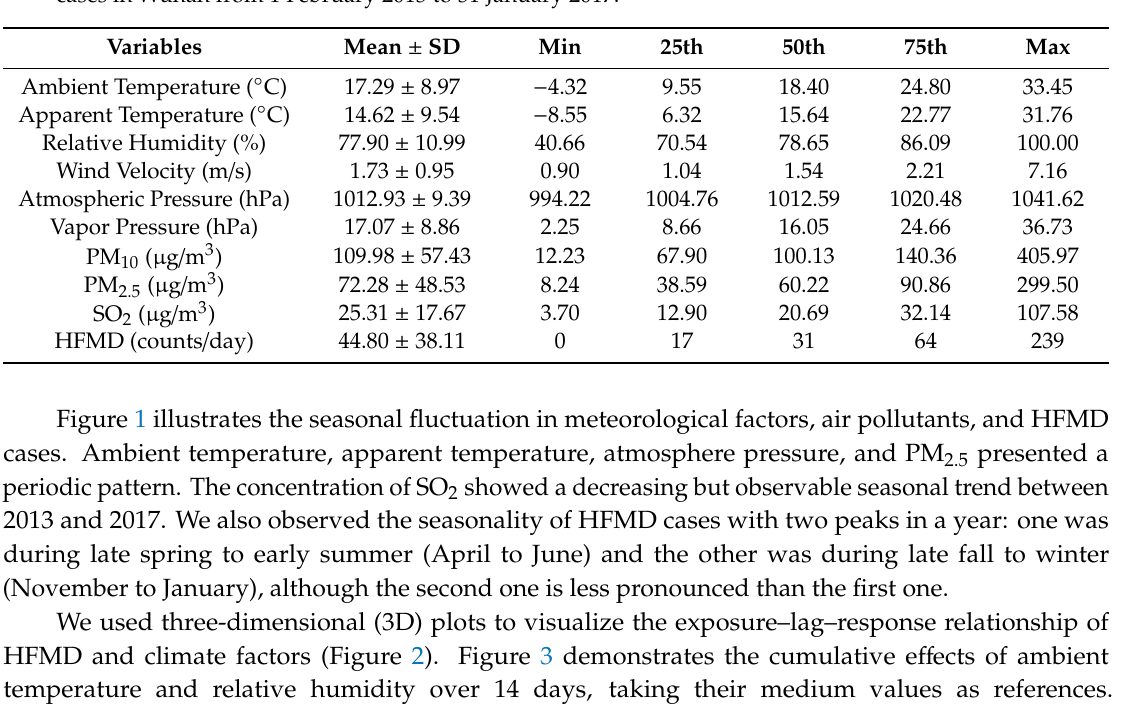
Table 1. Description of meteorological factors, air pollution, and hand, foot and mouth disease (HFMD) cases in Wuhan from 1 February 2013 to 31 January